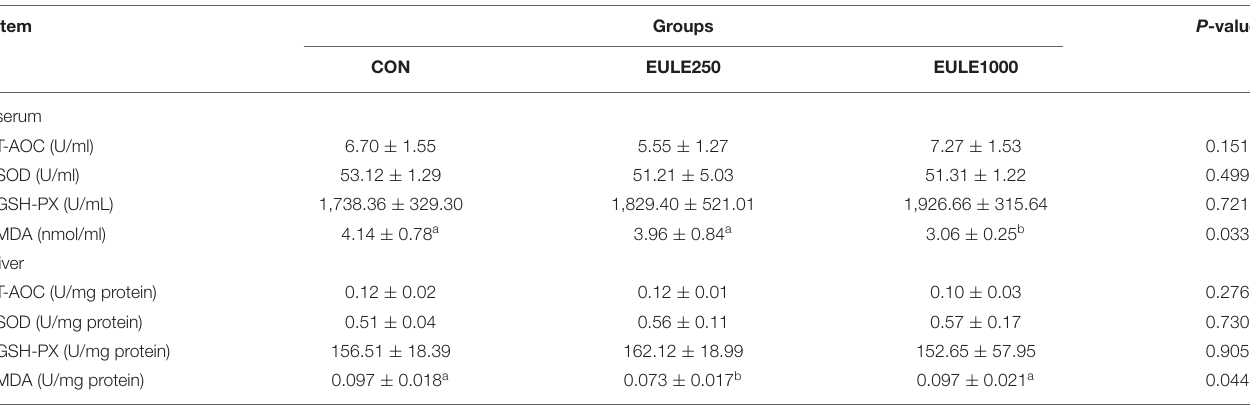
TABLE 2 | Effects of EULEs on antioxidant parameters in the serum and the liver.